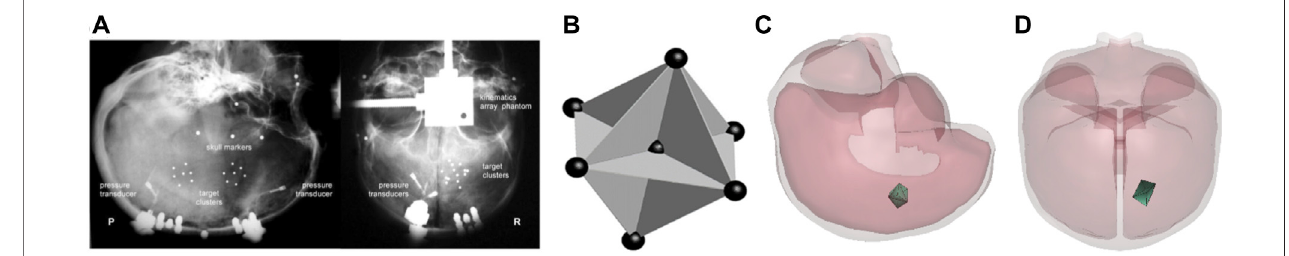
FIGURE 2 | (A) The location of NDT cluster in specimen C288 under representative instrumentation x-rays; (B) the NDT cluster implanting strategy in the impact tests of Hardy et al. (2007) [this picture is captured from Hardy et al. (2007) and represented with the permission from the Stapp Association]; (C) lateral view of null triad model embedded in case C288-T3; (D) anterior-posterior view of null triad model implanted in case C288-T3.